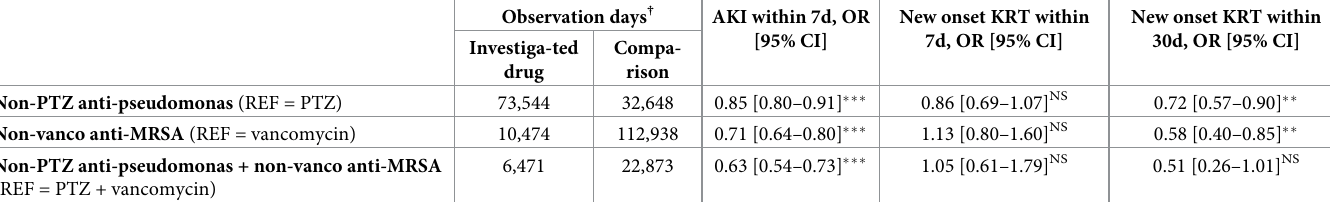
Results reported are Odds ratios with confidence intervals from a generalized estimating equation (binomial GEE) adjusted for: Age, sex, ethnicity, comorbidities (heart failure, liver disease and diabetes), SOFA score, hyperlactatemia, vasopressors, chronic kidney disease, antibiotic treatment duration, active bacteremia, positive ventilation, active corticosteroid therapy and leukopenia. Analyses for all anti-pseudomonal agents were also adjusted for the presence of a concomitant anti-MRSA agent, while analyses for anti-MRSA agents were adjusted for the presence of an anti-pseudomonal agent. † Observations where both investigated, and comparator antibiotics were concomitantly received and where KRT was ongoing (ie. not at risk of progression) were excluded from the